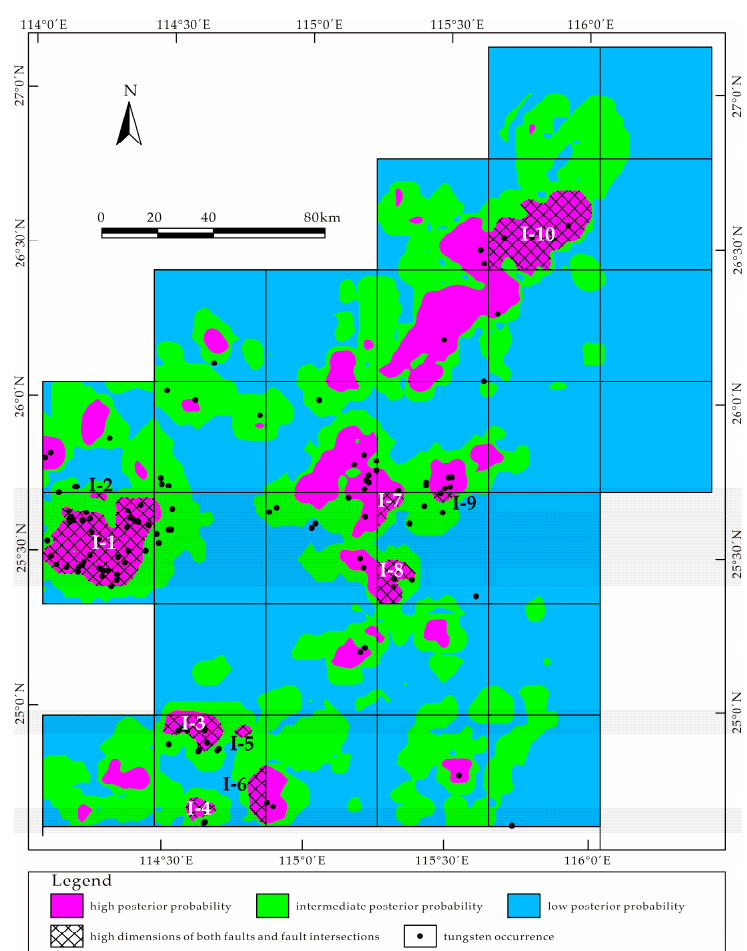
Figure 11. Predictive map based on the combination of both fractal analysis and WofE analysis.